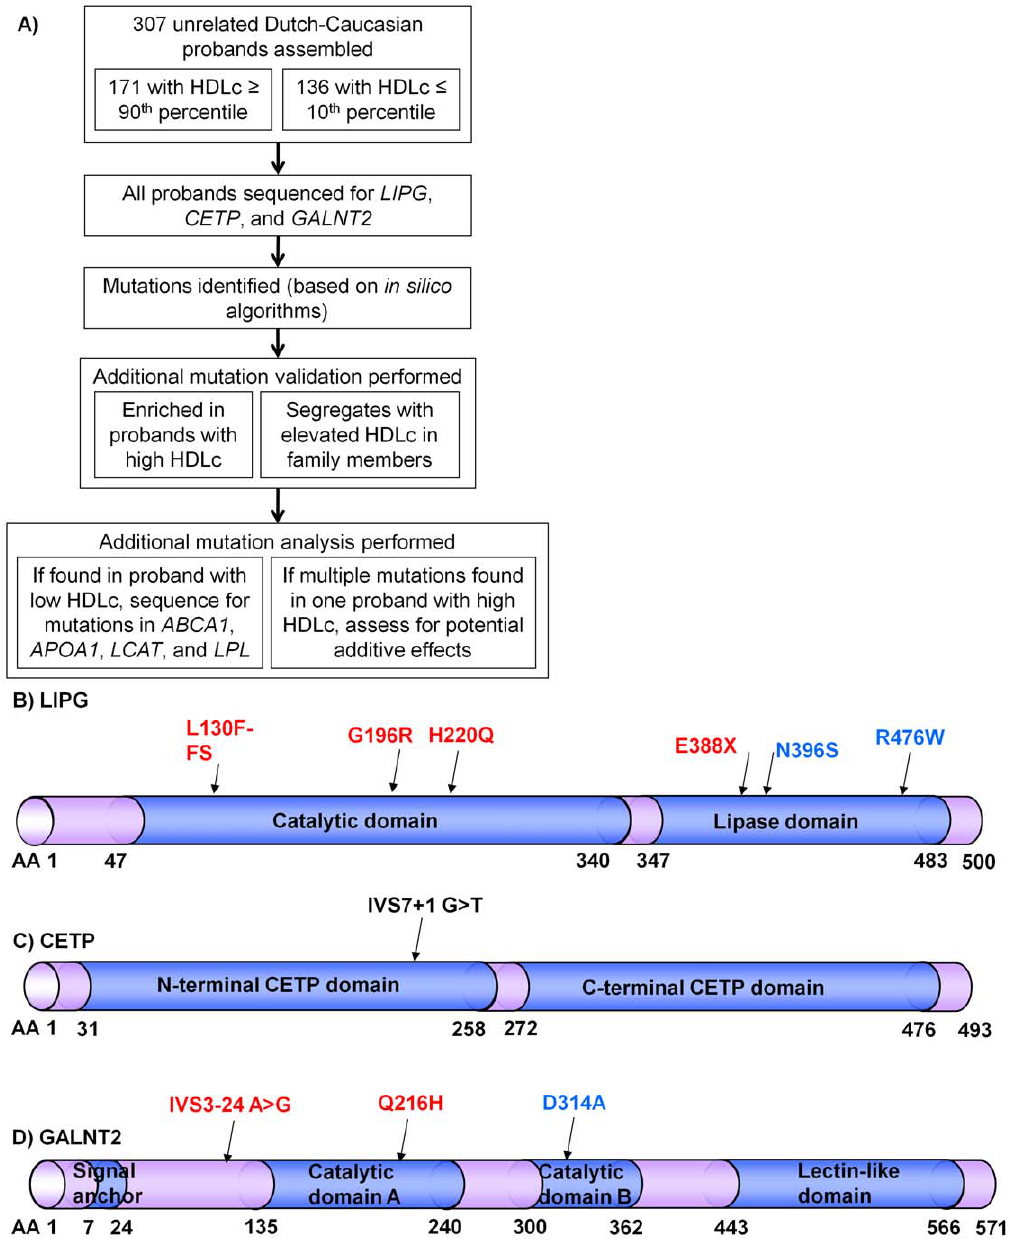
Figure 1. Mutations identified in probands with high or low HDLc. A) Overview of the study design. B–D ) Predicted mutation effects on B ) LIPG, C ) CETP, and D ) GALNT2 proteins. Red sequence changes are novel, blue are previously described [17,23,28], and black is previously described in a subset of this cohort [16].